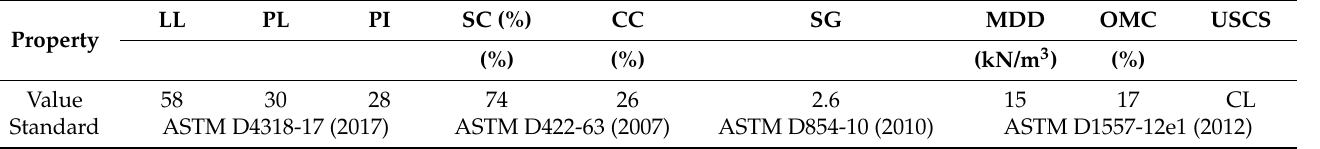
Table 2. Properties of